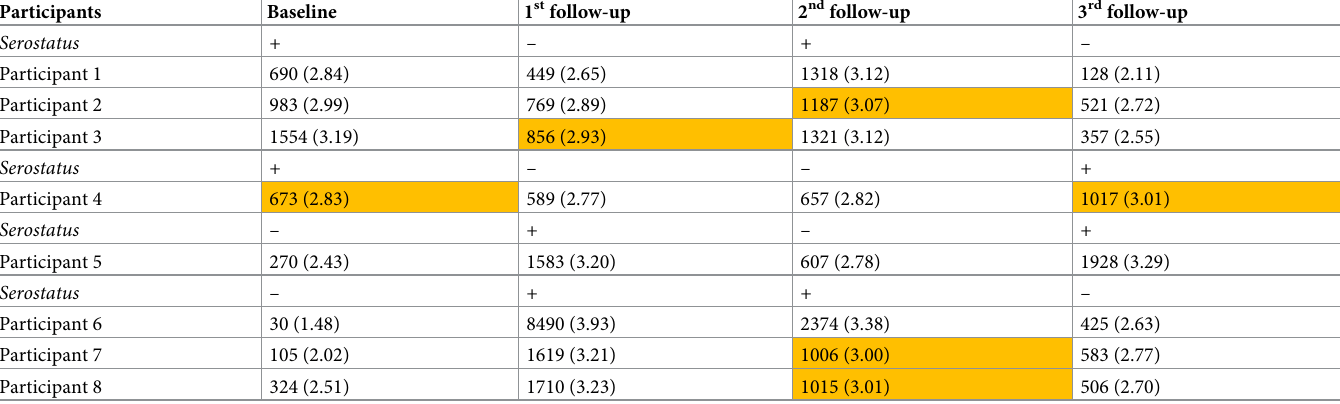
Table 5. MFI-BG (log MFI–BG) a of the unstable serostatus group at baseline and follow-ups. Highlighted cells contain MFI-BG values that fell in the indeterminant